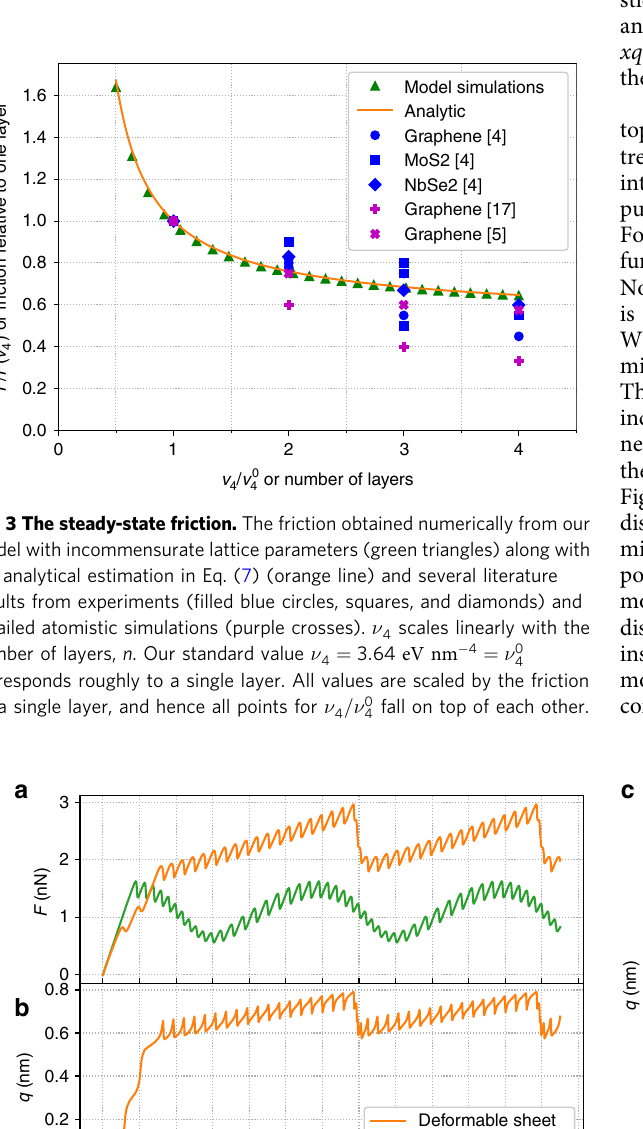
Fig. 4 Strengthening for an incommensurate case. Friction strengthening in a system with incommensurate lattice parameters but otherwise similar to Fig. 2, with (orange) and without (green) sheet deformation. The weakly incommensurate geometry of b = a ¼ 1 : 05 corresponds to a moiré pattern with long-range periodicity of 20 nm. The steady-state lateral force shows the additional effect of the substrate, especially the long period for the moiré pattern. Otherwise the behaviour of the system is very similar to Fig. 2. However, the pro fi le of the long-range periodicity is not sinusoidal, as would have been expected from a rigid sheet.